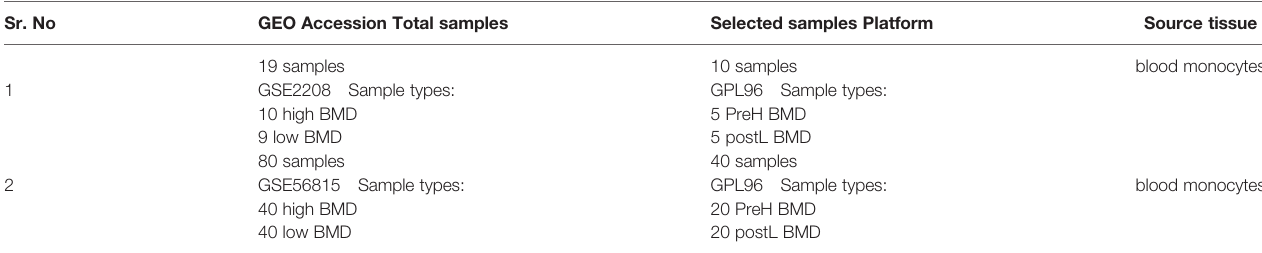
TABLE 1 | Information for selected microarray